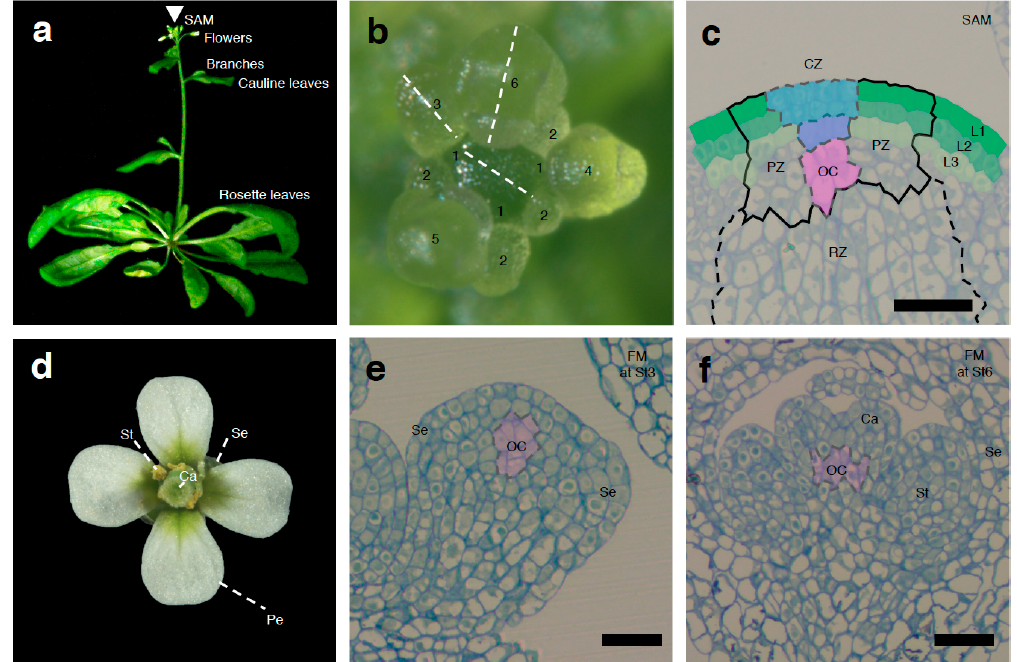
Figure 1. Morphology of the shoot apical meristem (SAM) and floral meristems (FM). ( a ) Side view of an Arabidopsis plant. Aerial tissues form from the SAM, which is located at the top of the plant (arrowhead). Thirty-day-old plants are shown. Lateral organs such as rosette leaves, cauline leaves, branches, and flowers form from the SAM. ( b ) Overhead view of the SAM. Numbers indicate floral stages [57]. The longitudinal sections shown in ( c , e , f ) were obtained by cutting across the SAM, stage 3 FM and stage 6 FM along the dashed lines, respectively. Thirty-day-old SAMs and FMs are shown. ( c ) Organization of the SAM showing functional zones and cell layers. The central zone (CZ) consists of stem cells (blue) and the organizing center (OC) (pink). PZ and RZ are the peripheral and rib zones, respectively. Epidermal (L1) and subepidermal (L2) layers are shown in green and light green, respectively. Scale bar = 20 µm. ( d ) Top view of an Arabidopsis flower at stage 13. A flower consists of four sepals, six stamens, four petals, and two carpels. A flower from a 30-day-old plant is shown. ( e ) Top view of the FM at stage 3. Scale bar = 20 µm. ( f ) Top view of the FM at stage 6. Organization of the FM showing functional zones and cell layers. The OC, which exhibits weak WUS expression only at stage 3 and early stage 6, is shown in pink. Scale bar = 20 µm.